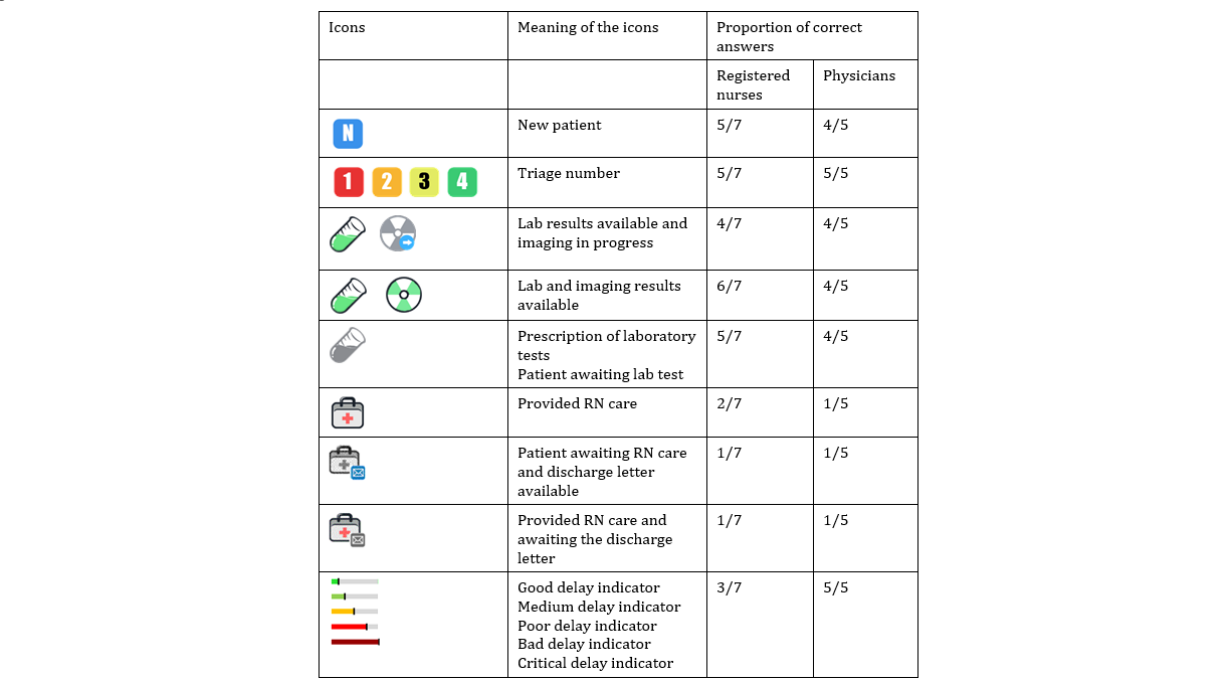
Figure 7. Results of phase 1 of the user testing: proportion of correct interpretation for each icon according to the profile of the participant. RN: registered nurse.